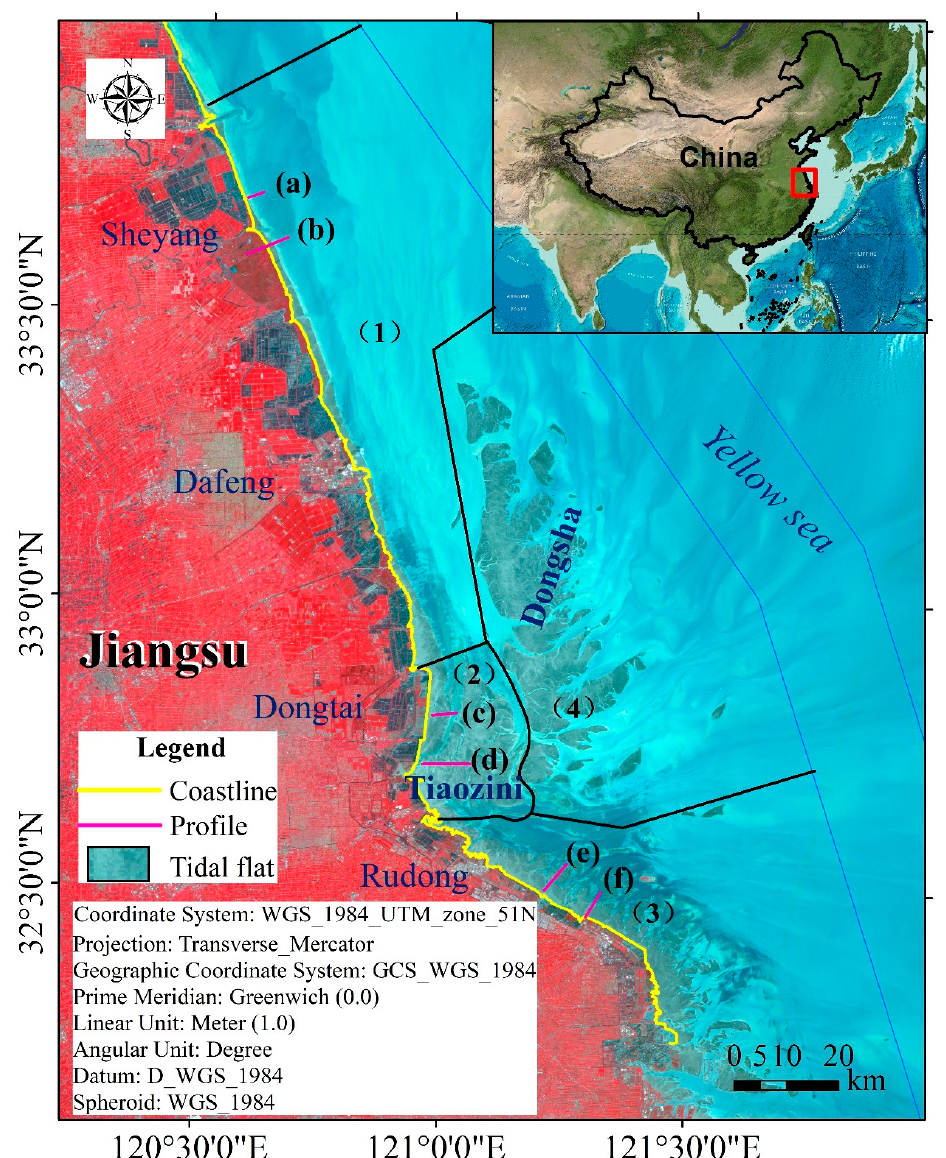
Figure 1. Geographical location map of the study area ((1) Northern Wing; (2) Inner part; (3) Southern Wing; (4) External part of the modern Radial Sand Ridges (RSRs)). (a), (b), (c), (d), (e) and (f) are typical cross sections in study area.